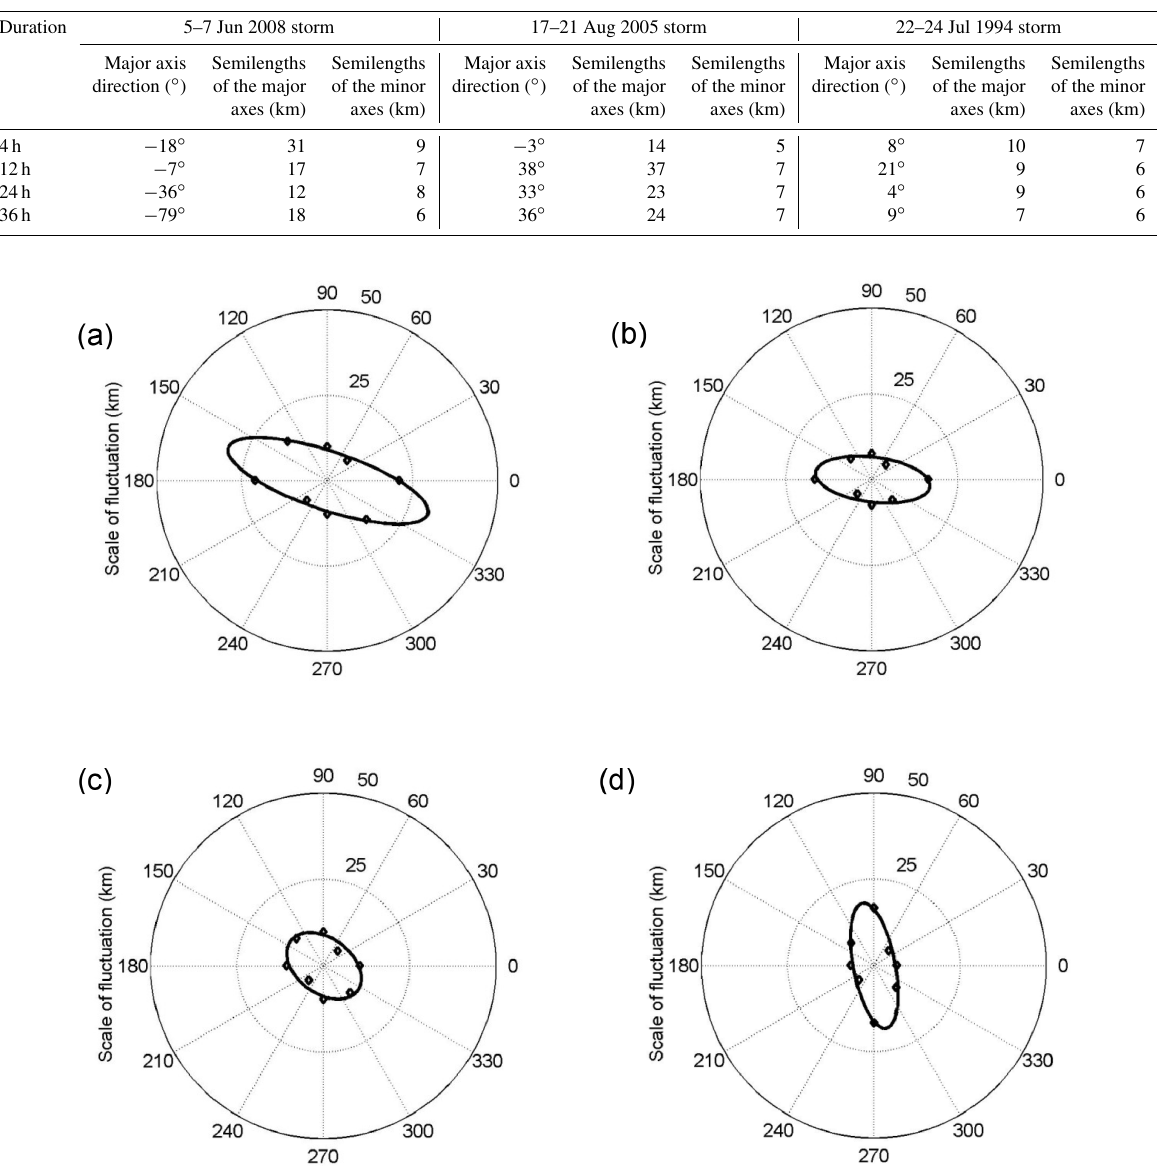
Table 4. Directions and semilengths of the axes of scale of fluctuation (SoF).